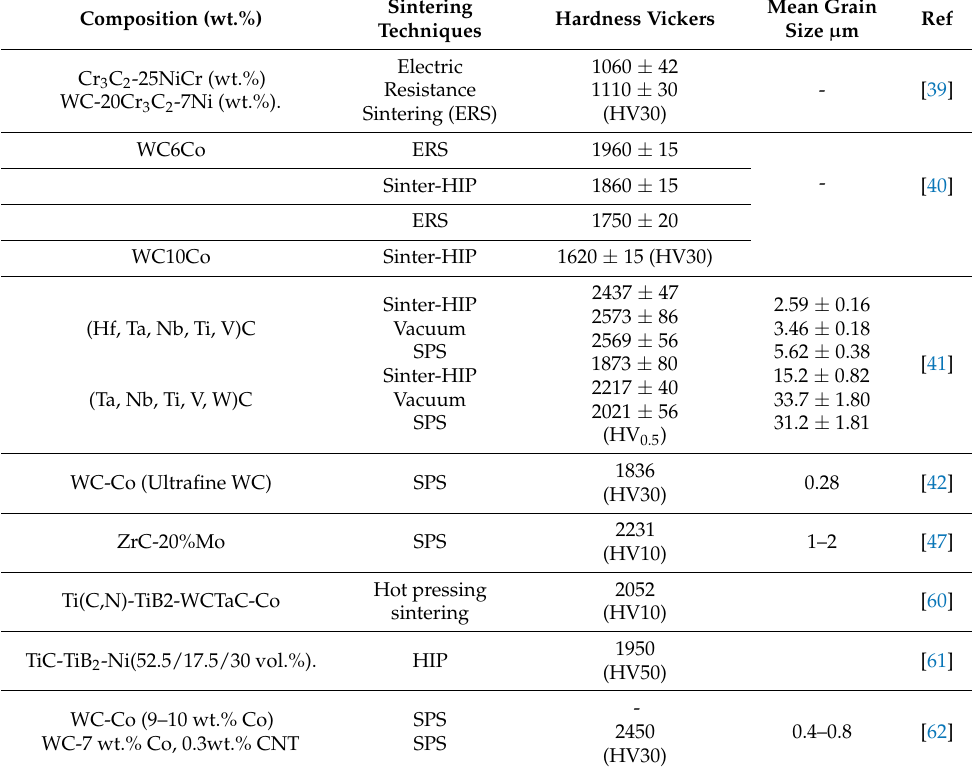
Table 1. Sintering techniques for preparation of cermets. Composition